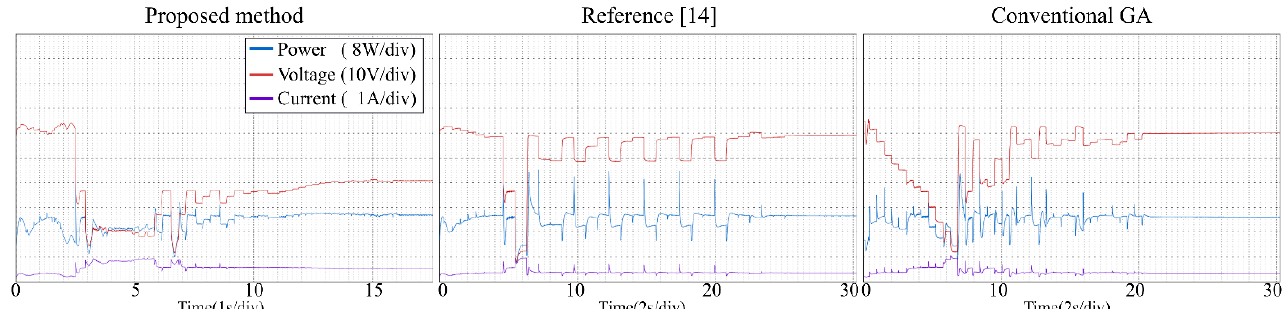
Table 4. Comparison of MPPT